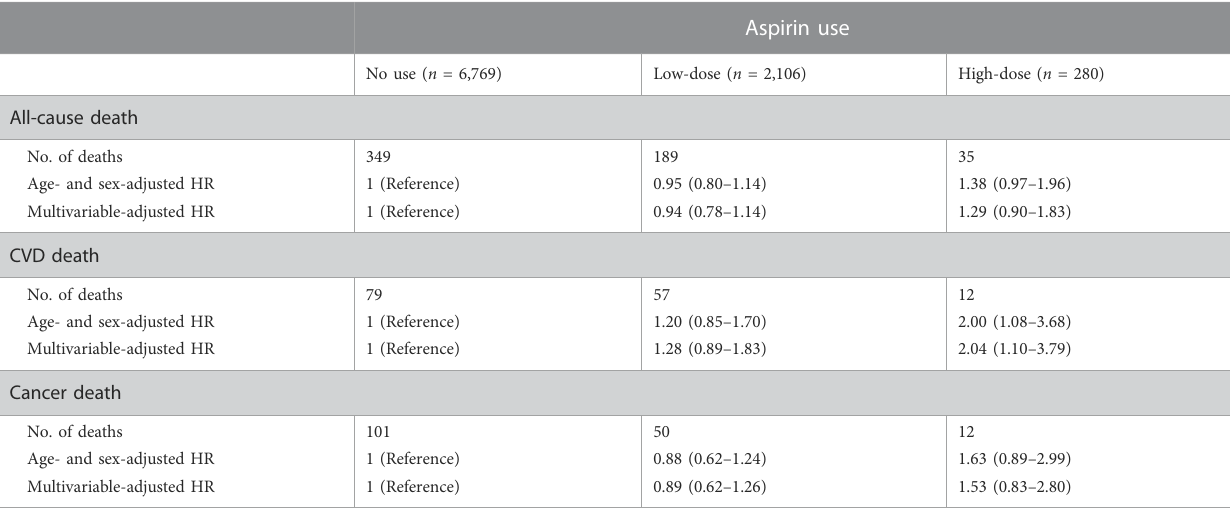
TABLE 4 Sensitivity analysis for the association between aspirin use and risk of death by excluding participants who had cardiovascular diseases at baseline ( n =